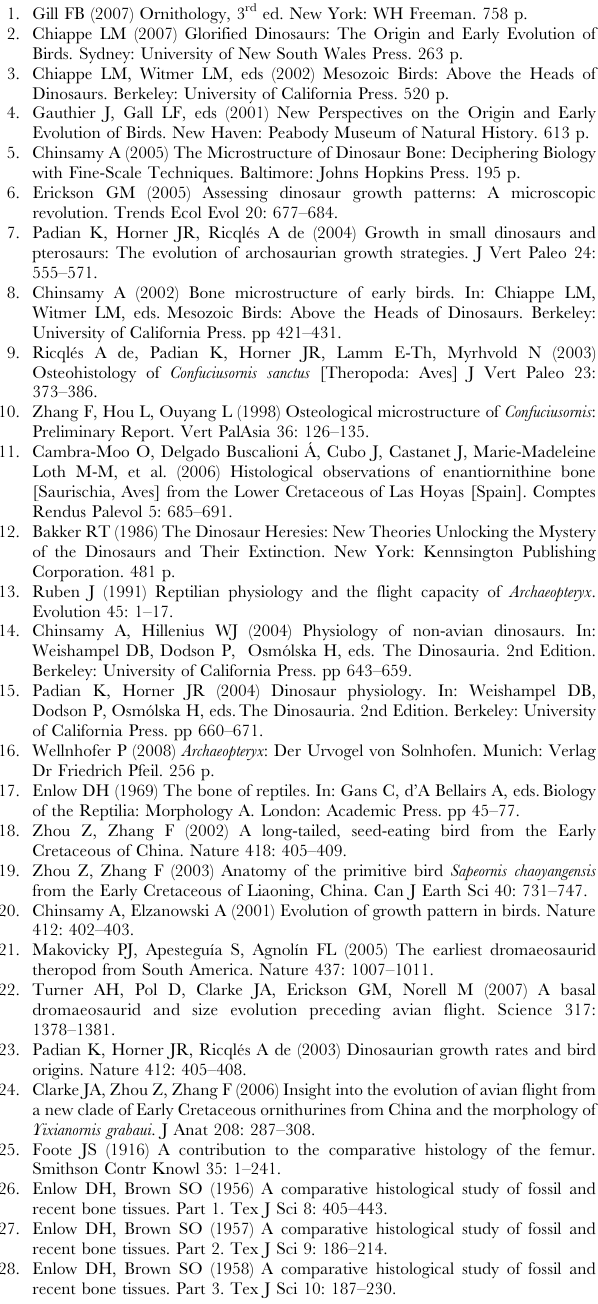
Figure S3 Long bone chips extracted from the Munich Archaeopteryx (BSP 1999 I